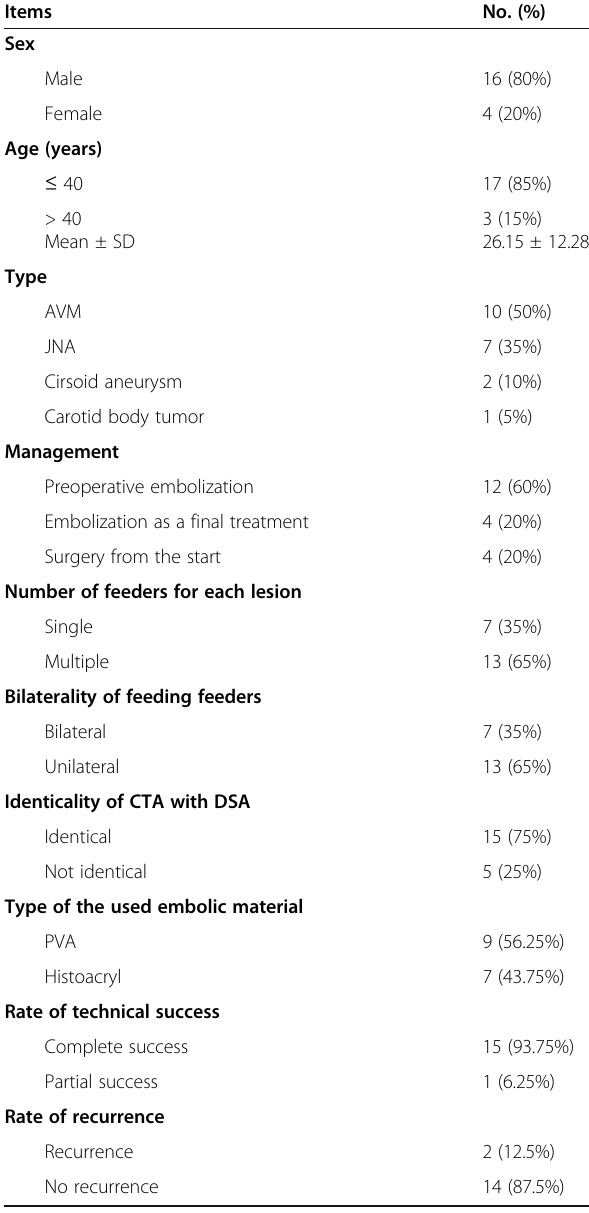
Table 1 Distribution of the studied cases according to